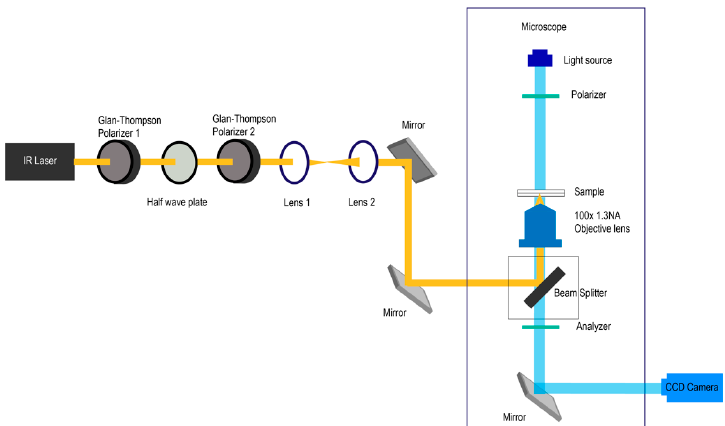
Figure 1. Schematic illustration of the optical tweezers setup on an inverted microscope.